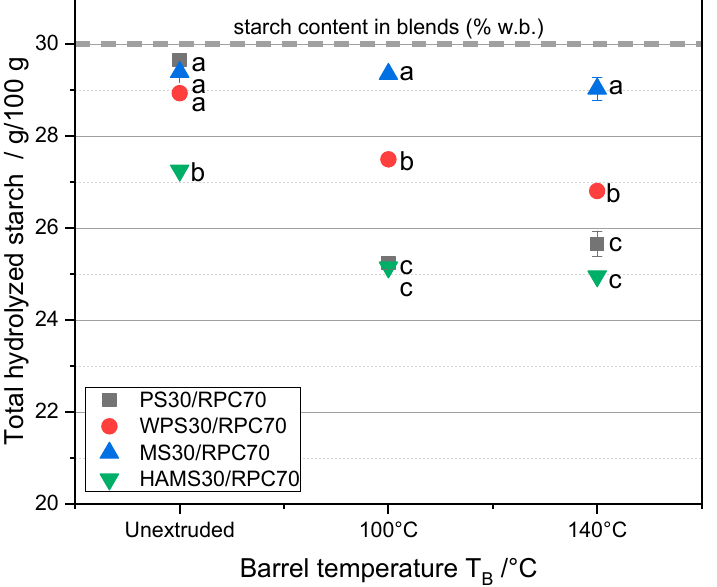
Figure 5. Content of total hydrolyzed starch (S H , g/100 g) of 70 g/100 g rapeseed press cake (RPC) mixed with 30 g/100 g potato starch (PS), waxy potato starch (WPS), maize starch (MS) and high- amylose maize starch (HAMS). Mean values with different superscript letters indicate significant differences ( p < 0.05) between the starch types based on a two-way analysis of variance (ANOVA). Where appropriate, the mean values were compared using Tukey’s honest significance